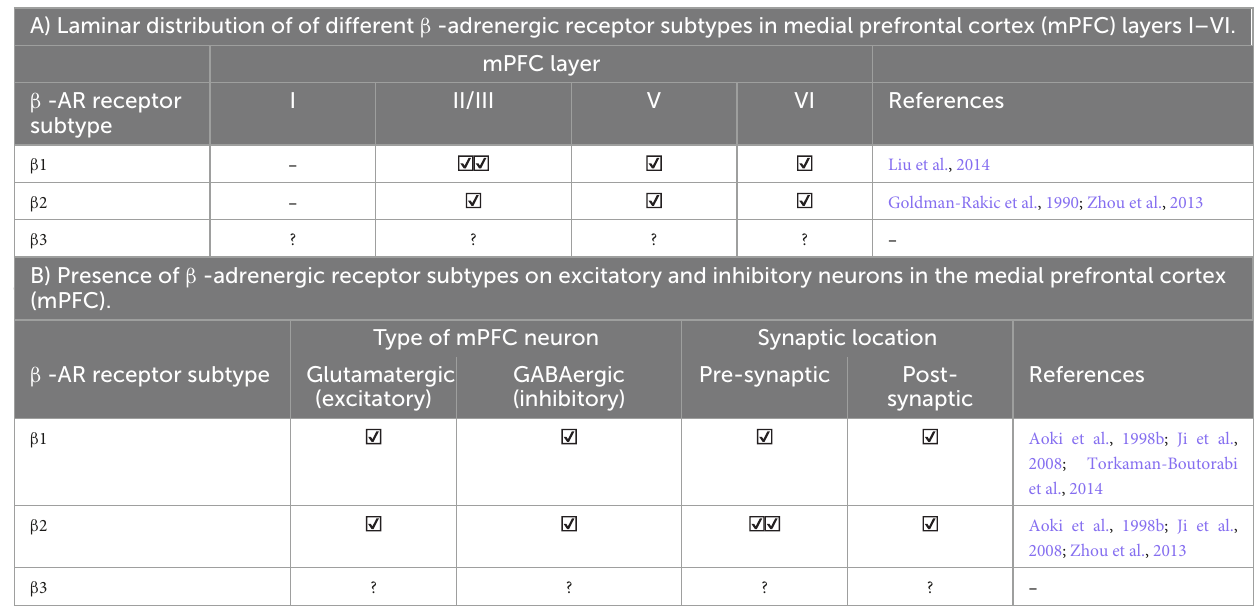
TABLE 2A Laminar and cellular distribution of β -adrenergic receptors in the medial prefrontal cortex (mPFC).